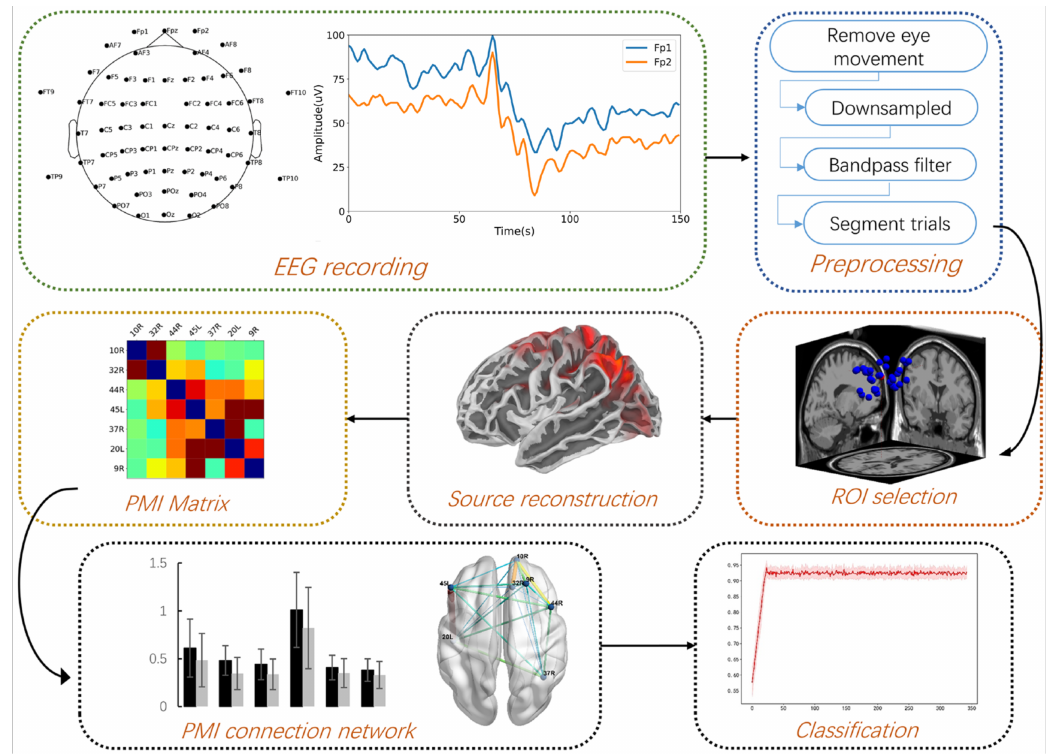
Figure 1. Flowchart of the proposed framework. The pipeline contains seven major steps: EEG recording, data preprocessing, ROI selection, source reconstruction, PMI matrix, PMI connection network, and FCN